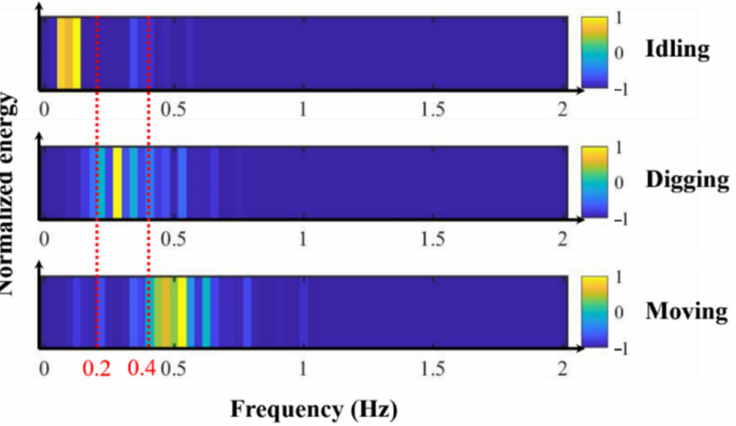
Figure 6. Typical energy spectral density comparisons of construction machinery in the idling, digging, and moving modes of operation. Periodic frequency of healthy adult respiration (0.2–0.4 Hz) was marked between the two red dotted lines.